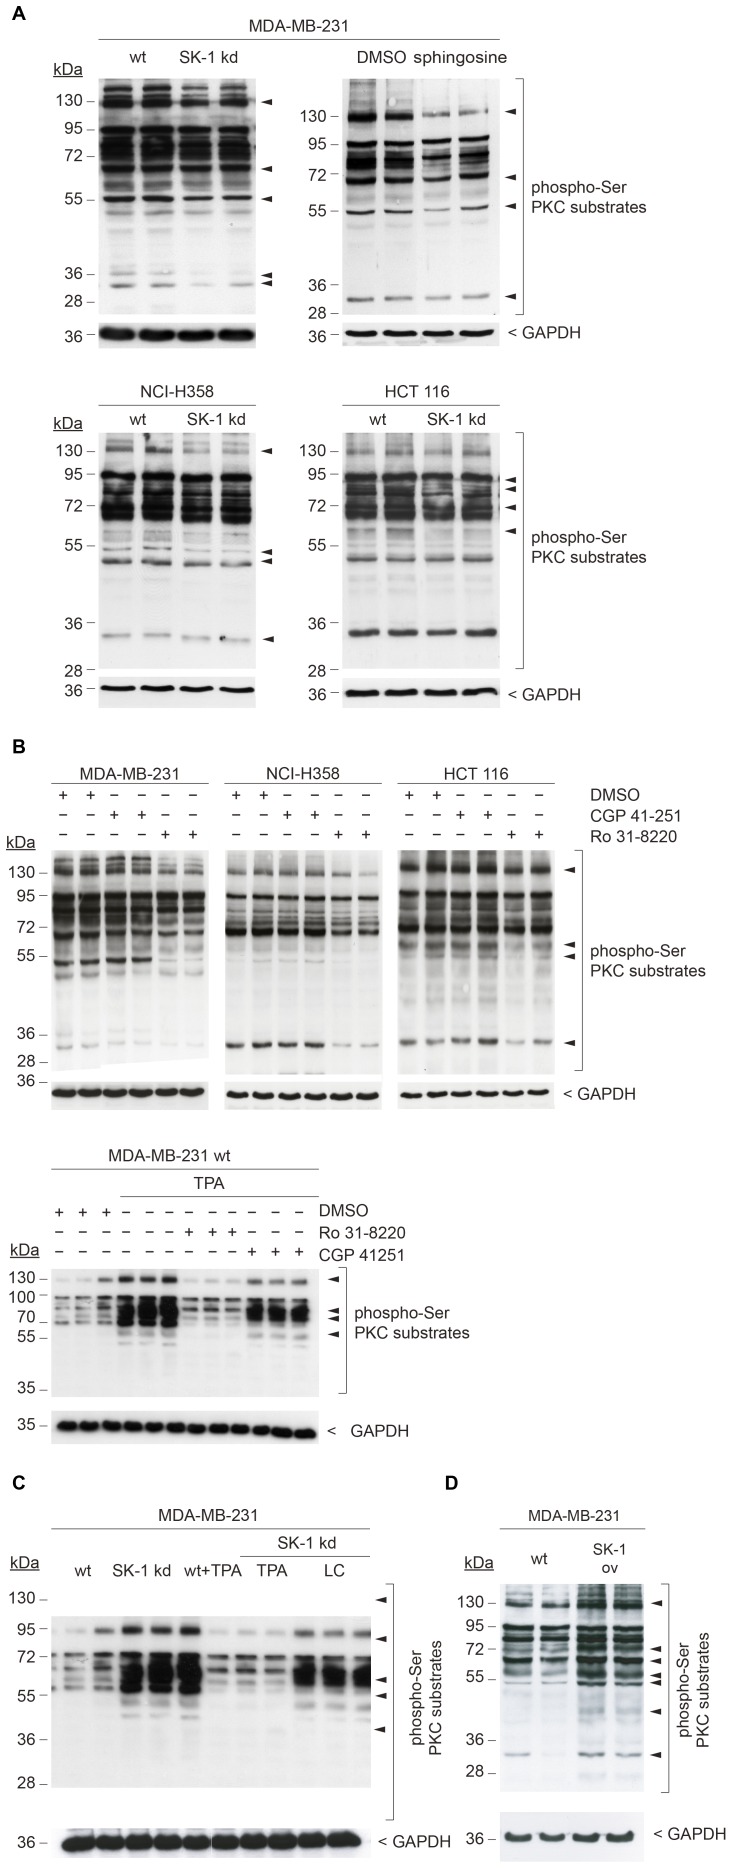
Downregulation of SK-1 increases sphingosine which inhibits PKC.(A) lysates were prepared from MDA-MB-231, NCI-H358, and HCT 116 wt and SK-1 kd cells, and analyzed for PKC activity by Western blotting using antibodies against various p(Ser) PKC substrates (dilution 1∶1000) or GAPDH (dilution 1∶2000) as loading control. MDA-MB-231 cells treated with sphingosine or DMSO vehicle control were analyzed for comparison. (B) cells were treated with the PKC inhibitors CGP 41-251 (300 nM) or Ro 31-8220 (1 µM) or with DMSO as control for 24 h before collection of lysates or quiescent MDA-MB-231 wt cells were pretreated for 4 h with the PKC inhibitors Ro 31-8220 (1 µM), CGP 41-251 (300 nM) or DMSO as control. Thereafter, cells were stimulated with the PKC activator TPA (200 nM) for 15 min. and lysates were analyzed for p(Ser) PKC substrates as described above. (C) quiescent MDA-MB-231 wt and SK-1 kd cells were stimulated with the PKC activator TPA (200 nM) for 15 min, treatment of SK-1 kd cells with lactacystin (20 µM for 24 h) was used to control for protein degradation. Lysates were analyzed for p(Ser) PKC substrates as described above. (D) MDA-MB-231 wt and SK-1 overexpressing (SK-1 ov) cells were analyzed for p(Ser) PKC substrates as described above.